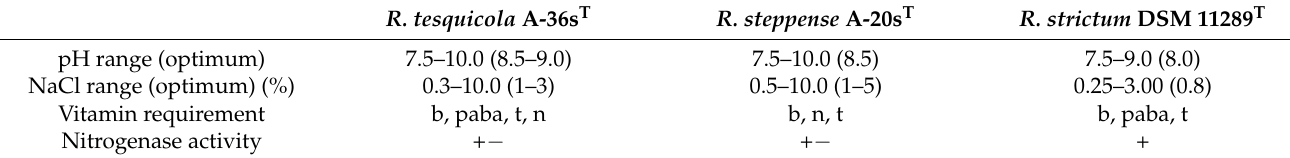
Table 2. Physiological features of R. tesquicola , R. steppense and R. strictum ([22], this study). b, Biotin; paba, p-aminobenzoate; t, thiamine; n, niacin; +, high nitrogenase activity rate; + − , moderate nitrogenase activity rate.